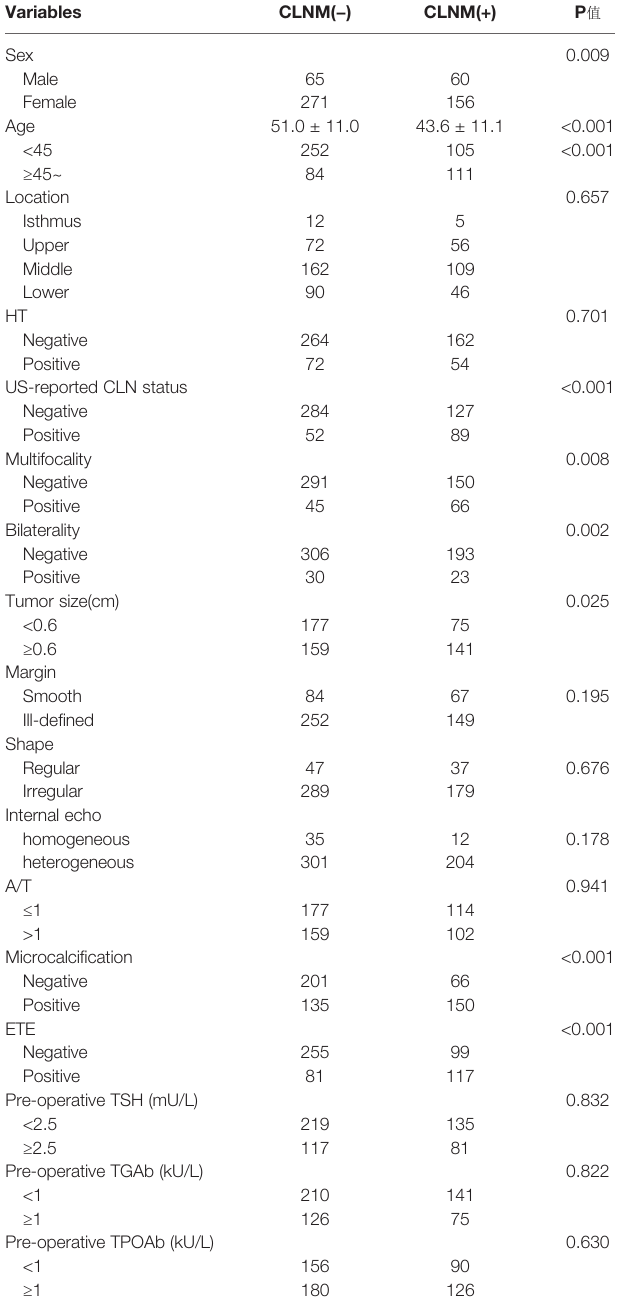
TABLE 1 | Clinicopathological characteristics and US features associated with CLNM in PTMC patients.